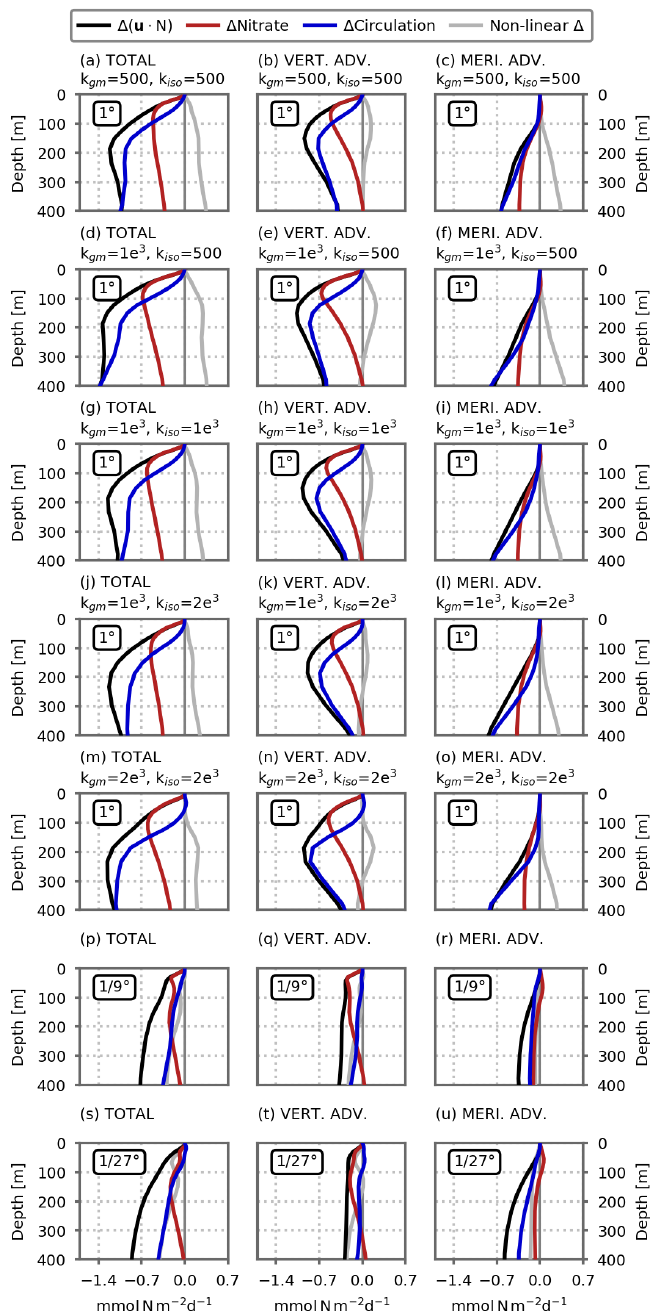
Figure A7. Vertical profiles of changes in advective nitrate supplies (black lines, mmolNm − 2 d − 1 ) broken into the nitrate distribution change term (red lines), circulation change term (blue lines) and residual non-linear term (gray lines). Changes are cumulated between the surface and depth D in the model’s subpolar box (dashed black lines in Fig. 3) and plotted against D . Change is the difference between climate change and preindustrial control simulations For details, see the Methodology section, Eqs. (3) to (6). The first column shows total advective fluxes which are the sum of the vertical advective fluxes at depth D (second column) and the meridional advective fluxes at the southern border (third column). Panels (a) – (o) show the five 1 ◦ resolution configurations, and (p) – (u) show the 1 / 9 and 1 / 27 ◦ resolution configurations. All figures show the average over the last 5 years of the simulations (years 66 to